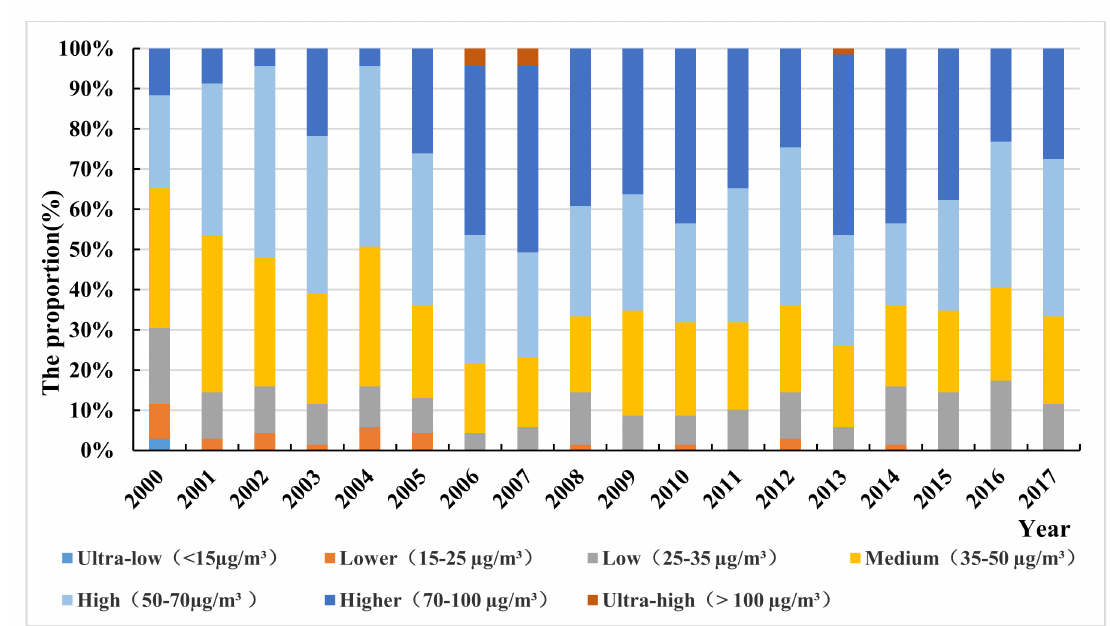
Figure 4. The proportion of different PM 2.5 concentration grades in 69 cities in the study area from 2000 to